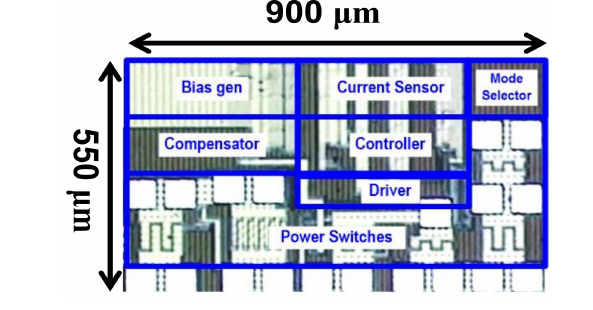
Figure 11. Chip micrograph.